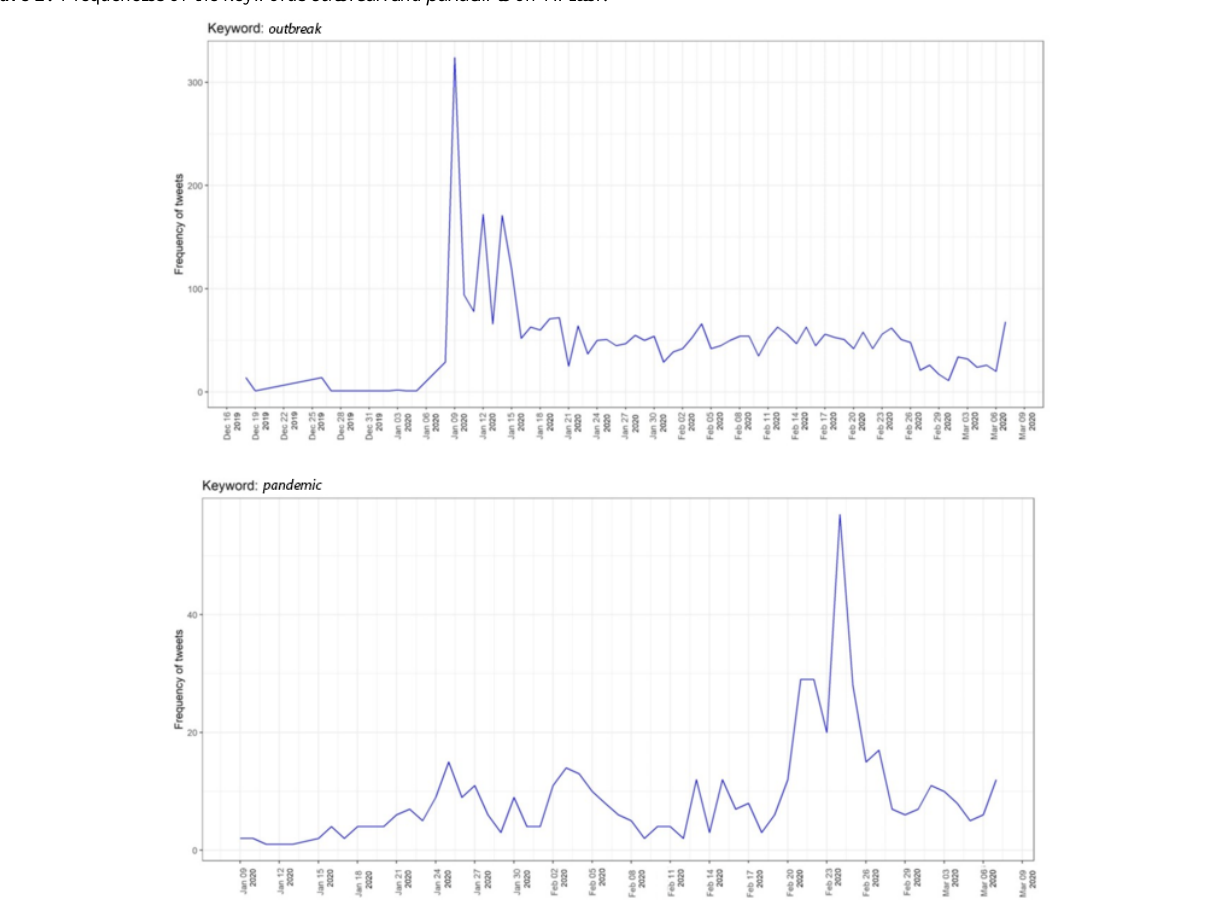
Figure 2. Frequencies of the keywords outbreak and pandemic on Twitter.